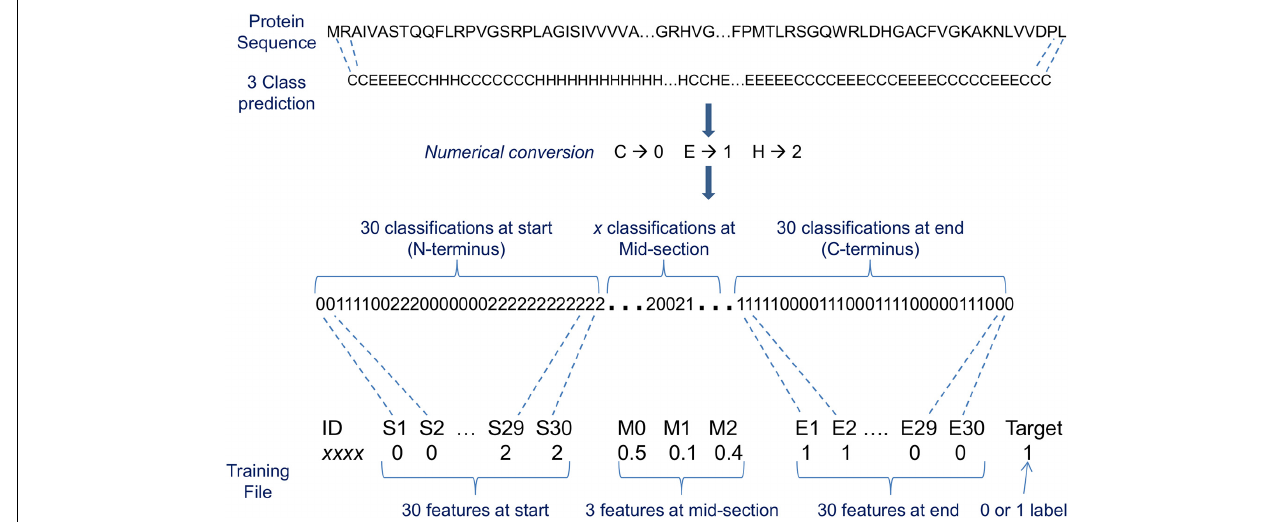
FIGURE 4 | An illustration of a machine learning input representation for 3 classification state predictions of protein conformation. The 3 classes are helix, sheet, and coil designated H, E, and C, respectively. ‘ x ’ classifications at mid-section denotes that a varying number of classifications exist between a nominated start and end number of classifications (in this instance, 30) because the source proteins vary in length. S1, S2, etc. are the consecutively numbered feature names at the start, and E1, E2, etc. are the consecutively numbered feature names at the end. M0, M1, and M2 are the mid-section feature names that contain the total number of classifications for each structural class divided by the number of mid-section classifications (e.g., for 8 classification state predictions the mid-section feature names are M0, M1, M2, M3, M4, M5, M6, and M7). The target is what the machine learning (ML) algorithm attempts to predict, i.e., exportome (positive) or non-exportome (negative), and features are what the ML algorithm uses to help make the prediction. In this illustration, the total number of features used to represent varying length proteins is 63 per